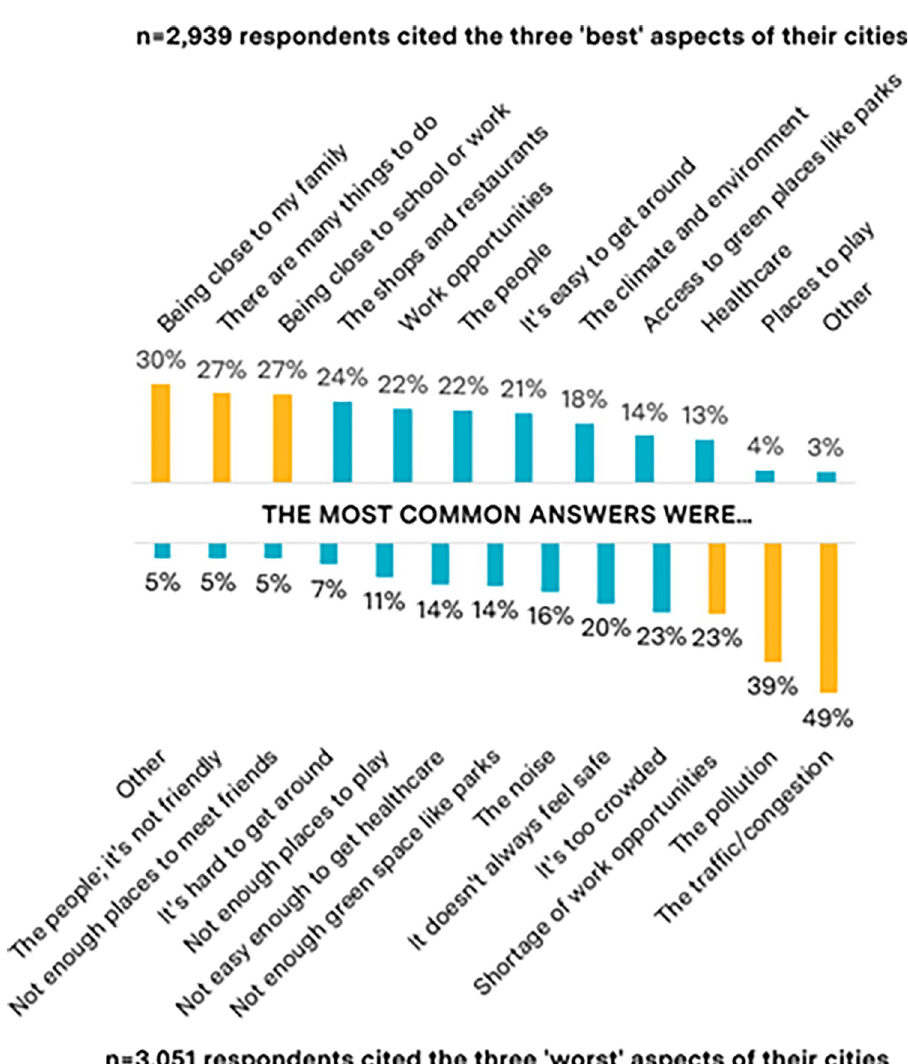
Fig 3. The percentage of n = 2,939 and n = 3,051 respondents that reported each item within the top 3 ’best’ and ’worst’ aspects of their